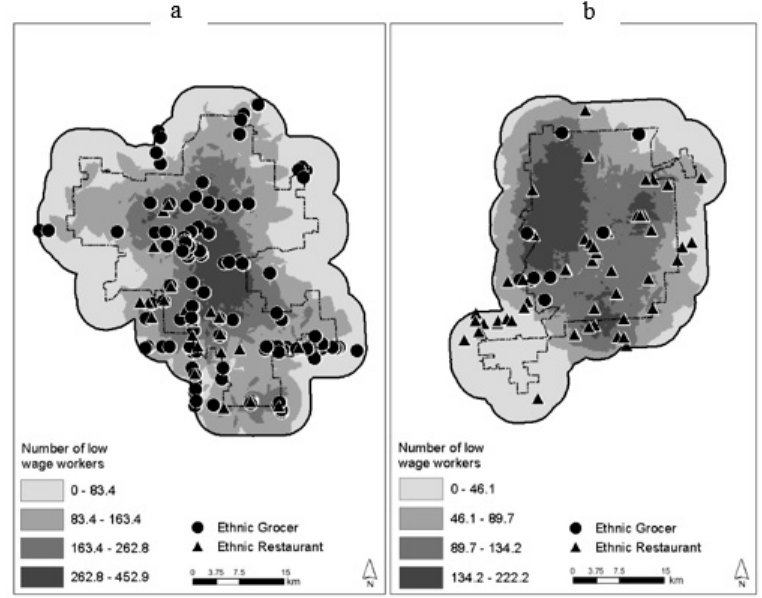
Figure 2. Spatial patterning of ethnic food outlet locations and density of low-wage employees within the study sites: Grand Rapids ( a ) and Flint ( b ), Michigan. Table 4. Moran’s I test of revealed accessibility index (RAI) in each city’s active living zone.